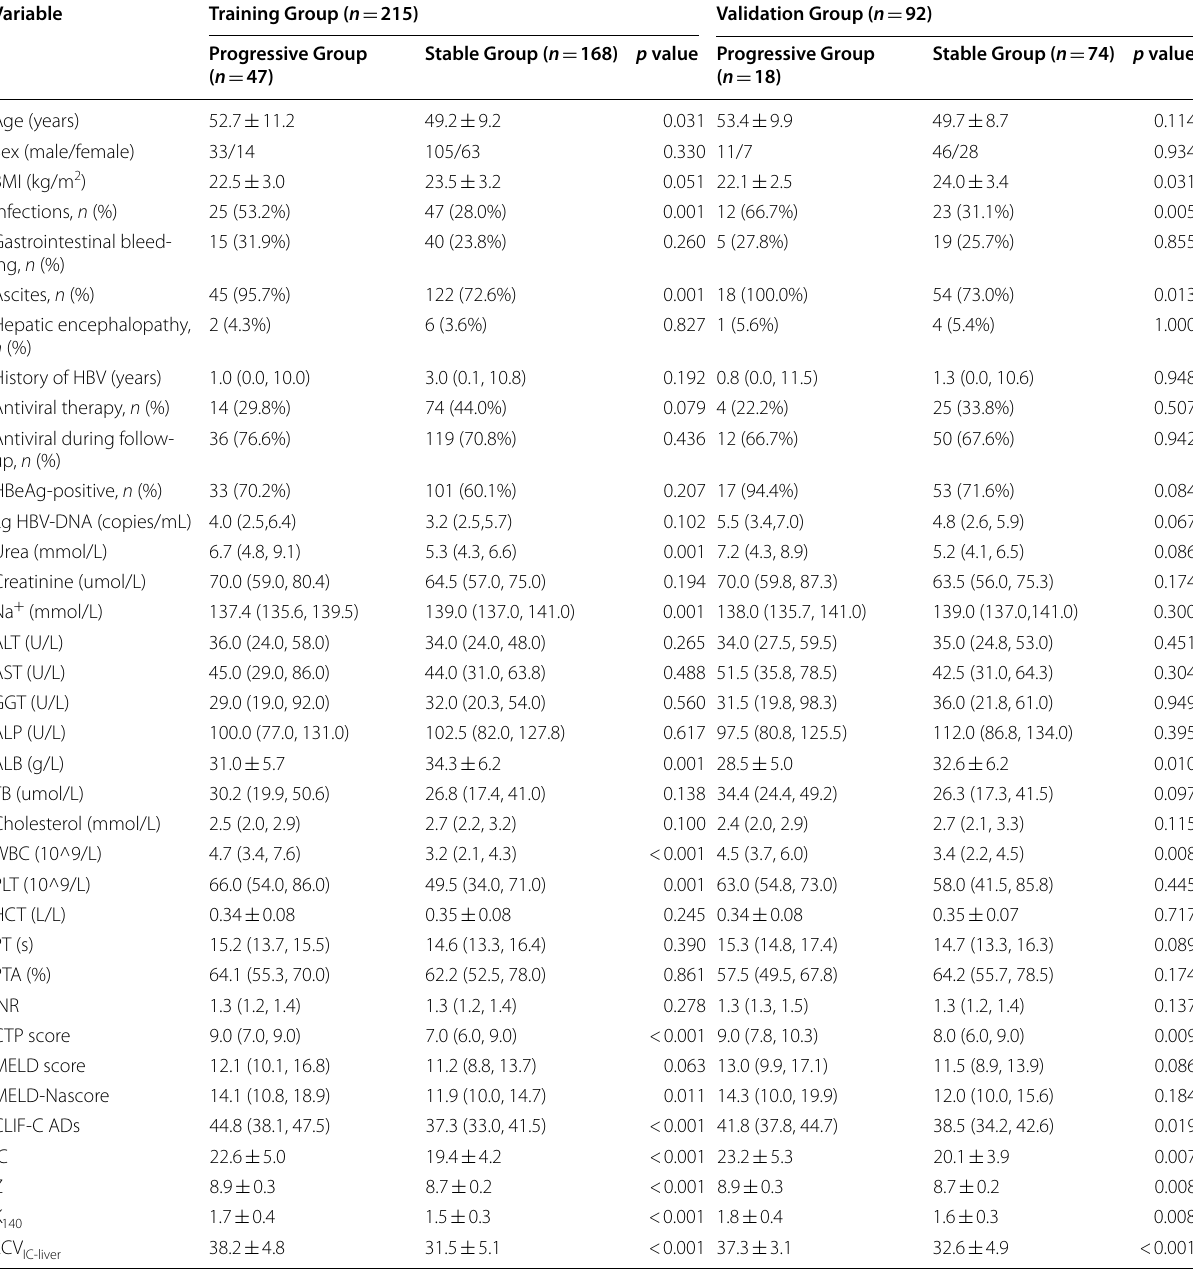
Table 2 Univariate analysis of risk factors associated with the occurrence of ACLF within 90